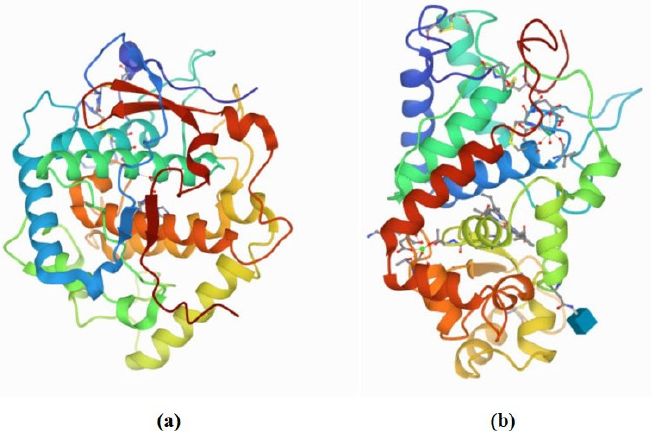
Figure 4. ( a ) Structure of grape ( Vitis vinifera ) PPO enzyme (Protein Data Bank entry: 2P3X); ( b ) structure of peanut ( Arachis hypogaea ) POD enzyme (Protein Data Bank entry: 1SCH).